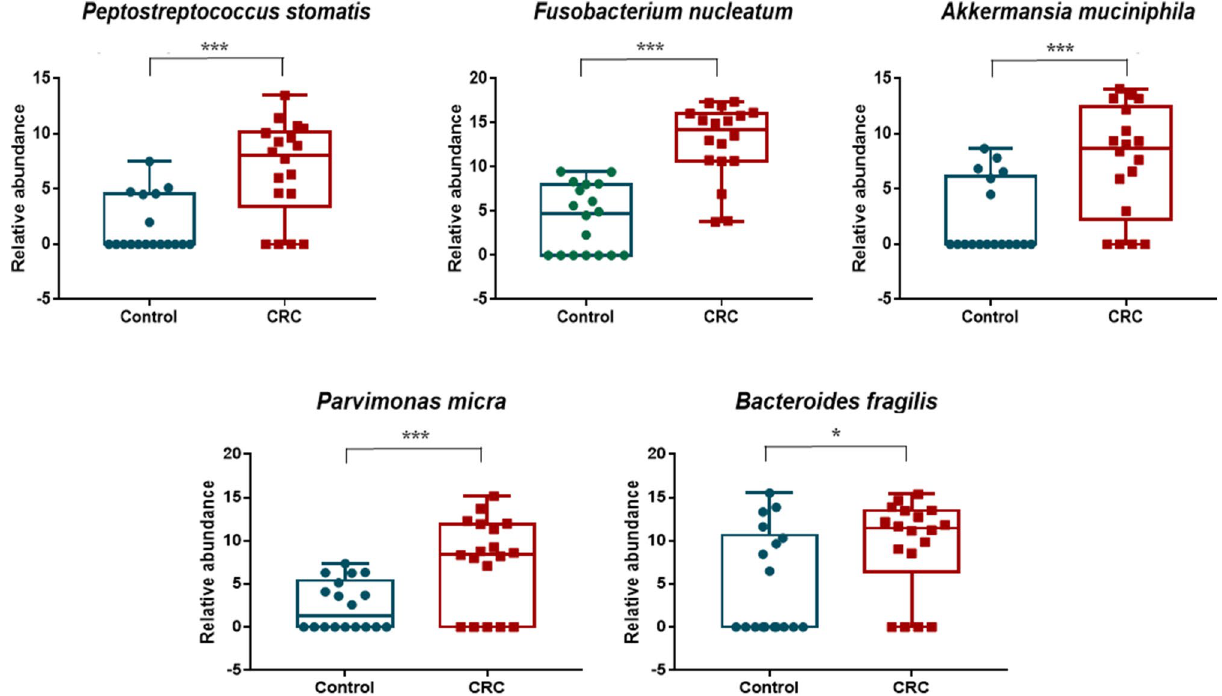
Figure 3. Gut bacteria identified to be over-represented in CRC patients compared to non-CRC controls. Boxplots show abundances of 5 bacterial species ( Fusobacterium nucleatum , Akkermansia muciniphila , Parvimonas micra , Peptostreptococcus stomatis and Bacteroides fragilis ) which were significantly over-abundant in CRC samples compared to non-CRC controls in the discovery cohort. Significance values: * < 0.05 and *** < 0.001.